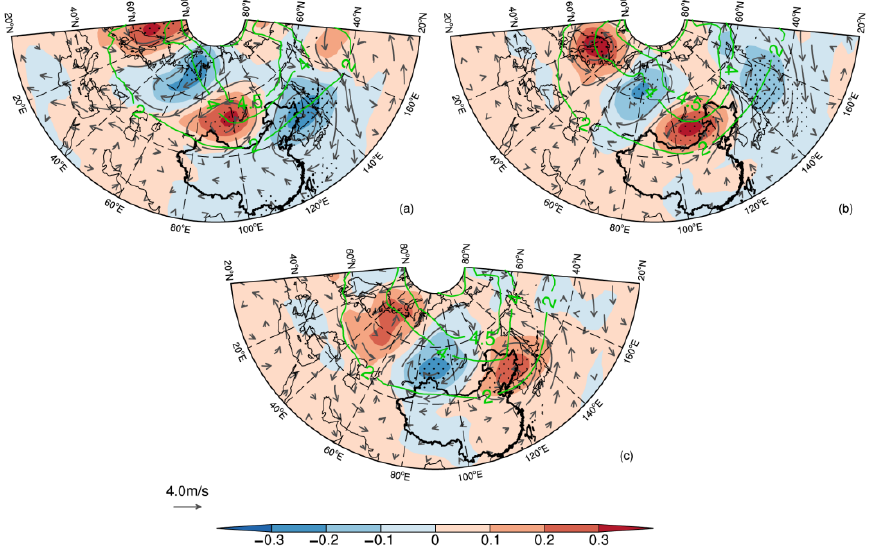
Figure 6. The IPV (contour, unit: PVU, 1 PVU = 10 − 6 m 2 ·K·s − 1 ·kg − 1 ) and 10–20 d low frequency IPV (shaded, unit: PVU, dotted area encloses regions of larger than 0.01 significance) on the 315 K isentropic surface at phase 3 ( a ), 5 ( b ), and 7 ( c ), respectively.